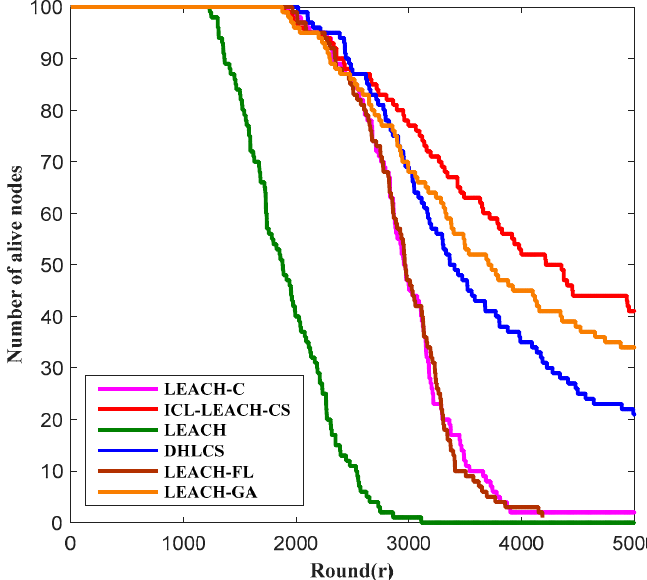
Figure 10. Number of alive nodes vs. round.